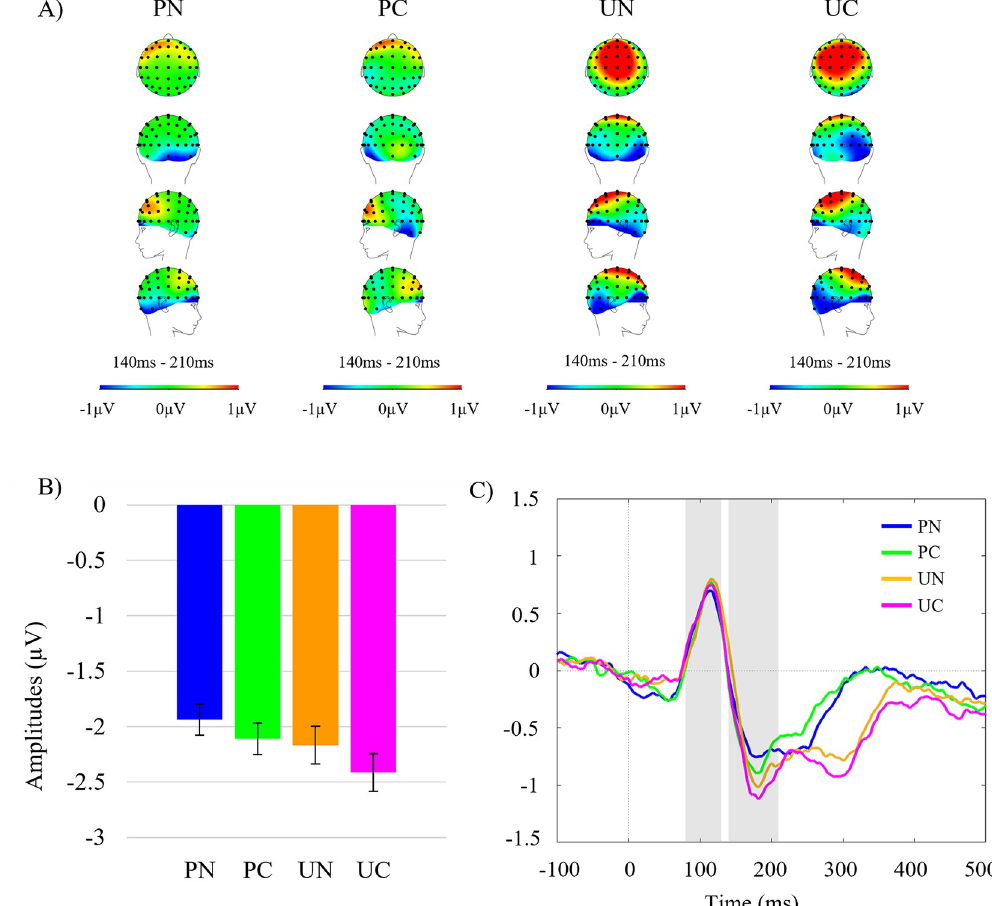
Fig 2. Grand average N170 topographies and amplitudes. A) Scalp topographies across all electrodes during the N170 time window for all conditions. From top to bottom: top, back, left, and right view. Heat map scales were set at -1 μ V minimum and 1 μ V maximum for display purposes. B) Grand averaged mean N170 amplitudes ( μ V) for all conditions pooled across left and right hemisphere electrode clusters. Error-bars denote 95% confidence intervals calculated for repeated measures using the Cousineau-Morey Method [53]. C) Grand averaged waveforms pooled across hemispheres for all four conditions. Grey panels indicate the time windows tested with P1 80-130ms, and N170 140-210ms. PN = predictable non-cued, PC = predictable cued, UN = unpredictable non-cued, and UC = unpredictable cued